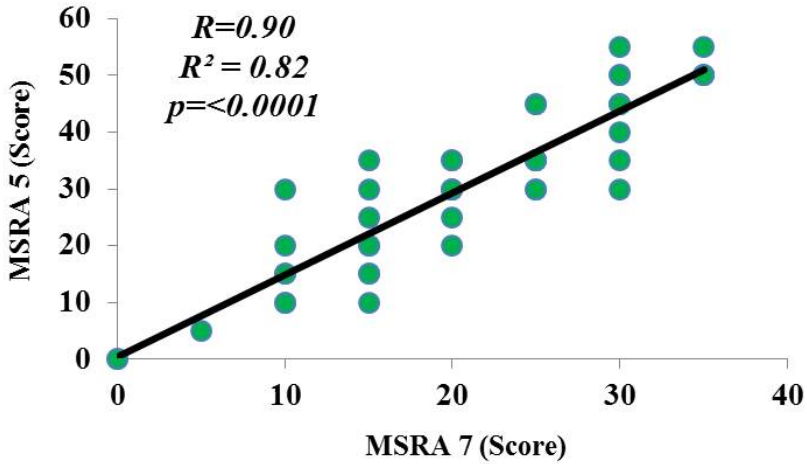
Figure 2. Correlation coefficient between MSRA-7 (full version) and -5 (short version) items. MSRA: Mini Sarcopenia Risk Assessment questionnaire. p < 0.05 was considered as significant.